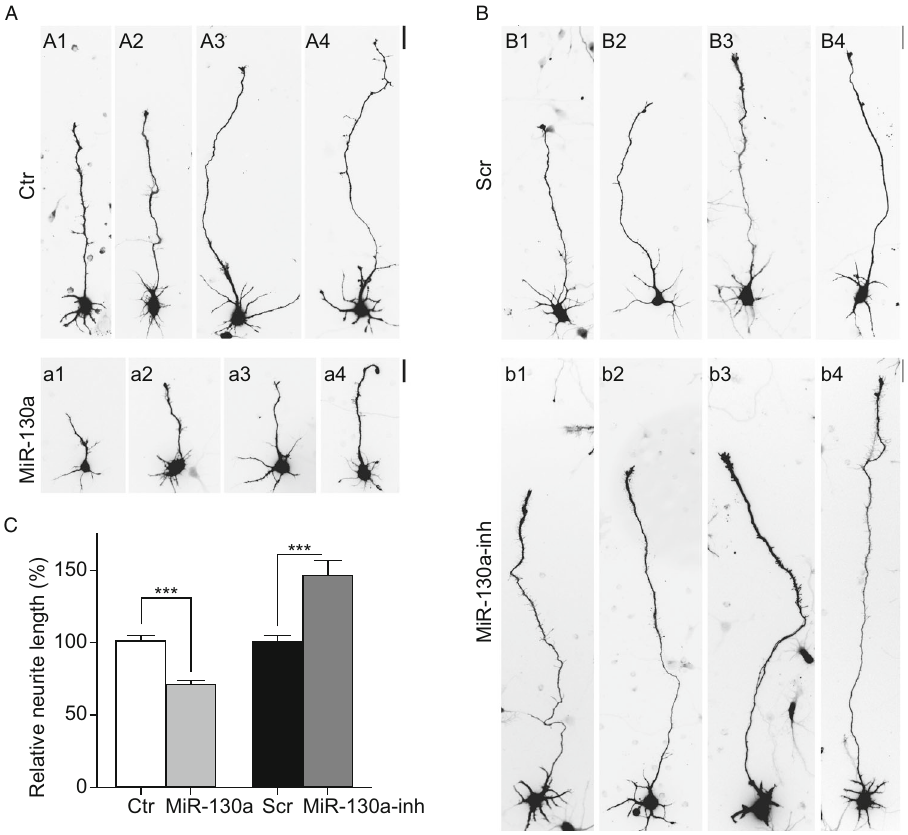
Figure 2. MiR-130a decreases the length of neurites in cultured primary cortical neurons. (A) Cortical neurons isolated from E18 rat embryos were electroporated with the vector control (Ctr; upper panels A1 – A4) or the miR-130a expression plasmid (lower panels a1 – a4) and cultured for 3 days. Representative images of neurons are shown from either control or miR-130a groups to illustrate the range of neurite outgrowth. Scale bar: 25 μ m. (B) Cortical neurons from E18 embryos were electroporated with the scrambled RNA control (Scr; upper panels B1 – B4) or the miR-130a inhibitor (MiR-130a-inh; lower panels b1 – b4) and cultured for 3 days. Representative images of neurons are shown for the corresponding groups to illustrate the range of neurite outgrowth. Scale bar: 25 μ m. (C) Quanti fi cation of the average lengths of the longest neurites (mean values ± SEM) in experiments shown in panels (A) and (B). At least 100 neurons in each group were randomly selected and scored in each experiment. ***, P < 0.001, Mann- Whitney test. Data represent three independent